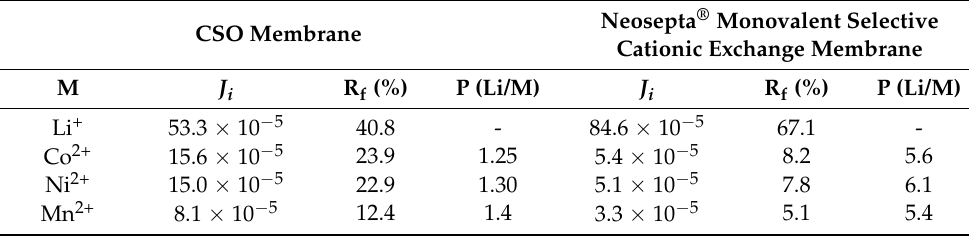
Table 1. Permselectivity index for lithium towards the M (P(Li/M)), faradic efficiency (R f ), and cation flux ( J i in mol m − 2 s − 1 ) of i = lithium(I), cobalt(II), nickel(II) and manganese(II) after 270 min of electrodialysis when the CSO membrane or the Neosepta ® monovalent-selective cationic exchange membrane was used in the ED cell displayed in Figure 1b. Current density = 12.5 mA cm − 2 ; Flow rate = 100 mL min − 1 in all compartments; Anodic and cathodic solutions: 0.1 M H 2 SO 4 ; pH = 2.8 in the leaching solution to increase the faradic efficiency.